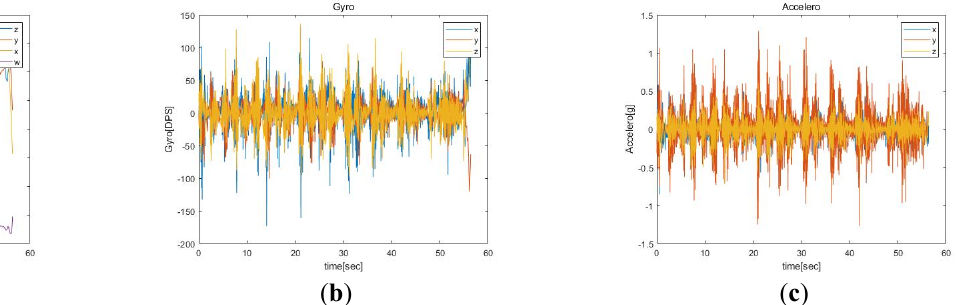
Figure 3. ( a ) Representative quaternion data, ( b ) gyro data, and ( c ) acceleration data measured with IMU sensors during Ex1.